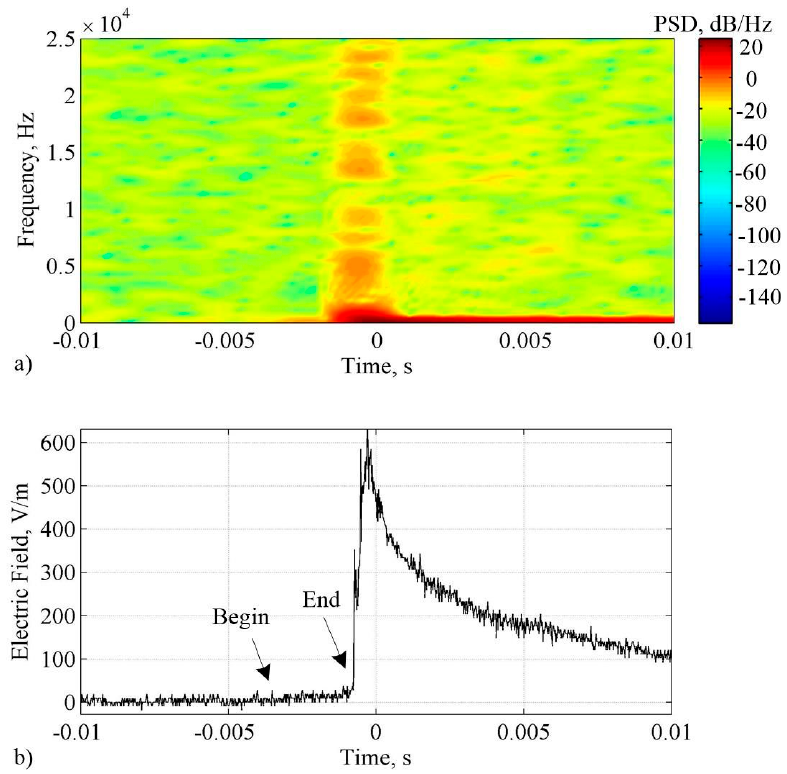
Figure 5. Description the same as in Figure 4, except for parameters of the Case #5 indicated in Table 1.